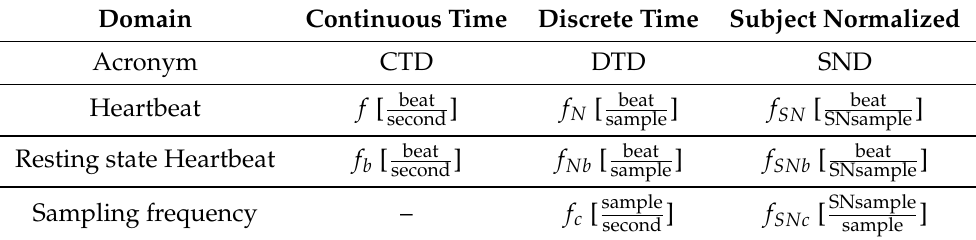
Table 2. Correspondences between the three domains. Domain Continuous Time Discrete